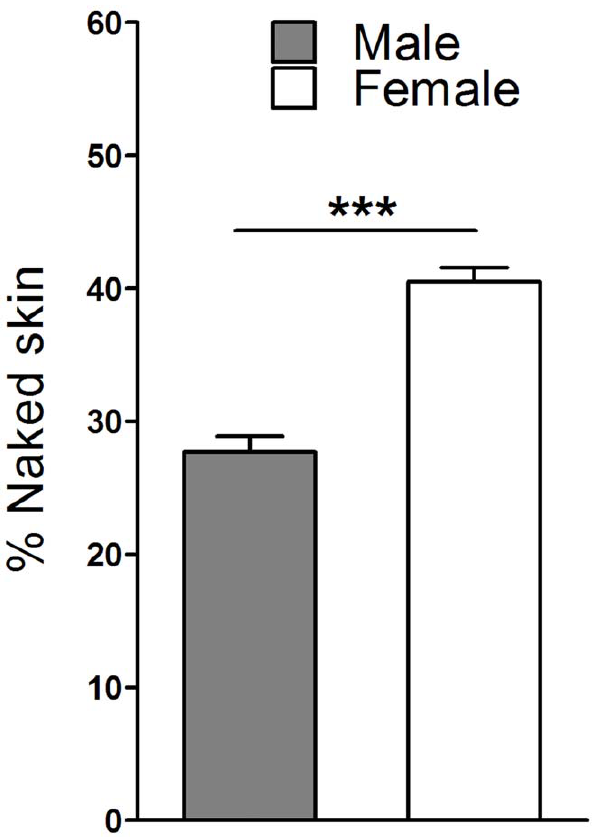
Figure 3. Contribution of users’ sex to skin disclosure among male and female avatars. Potential sex swapping among users was accounted for by excluding the top 25% of female avatars that exposed most skin and the bottom 25% of male avatars that exposed least skin. Even after excluding these avatars, the remaining female avatars revealed significantly more skin than remaining male avatars. Results are presented as means 6 SEM. *** p , 0.001.